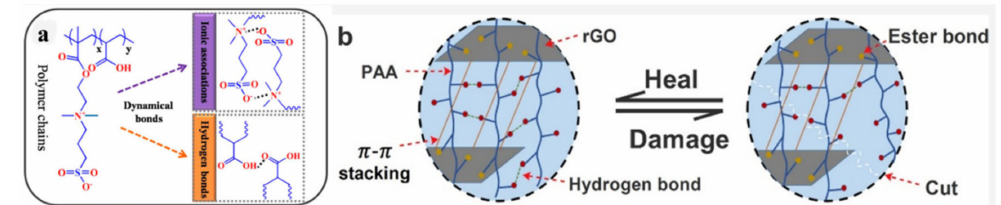
Figure 45. ( a ) Schematic representation of dynamical bonds between cross-linked polymer chains. Reprinted with permission from [207]. Copyright (2020) American Chemical Society. ( b ) Mechanism of self-healing of PAA-rGO elastomers. Reprinted with permission from [208]. Copyright (2020) American Chemical